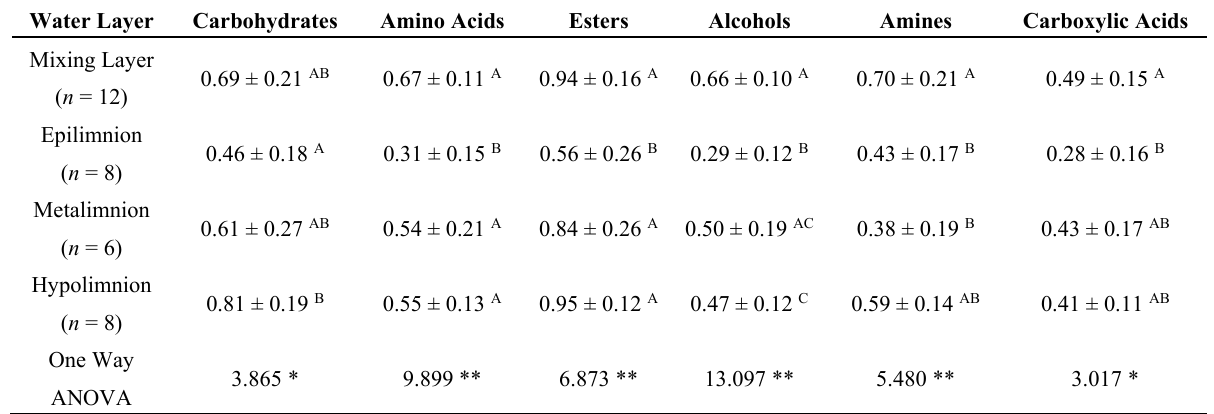
Table 2. Variance analysis of utilization of the six groups of carbon sources in Biolog ECO plate by bacterial communities of each water layer in the Jinpen Drinking Water Reservoir,